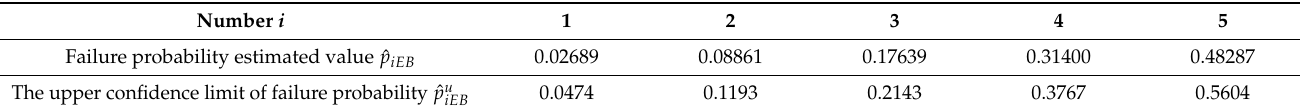
Table 4. Failure probability and upper confidence limit point estimation.